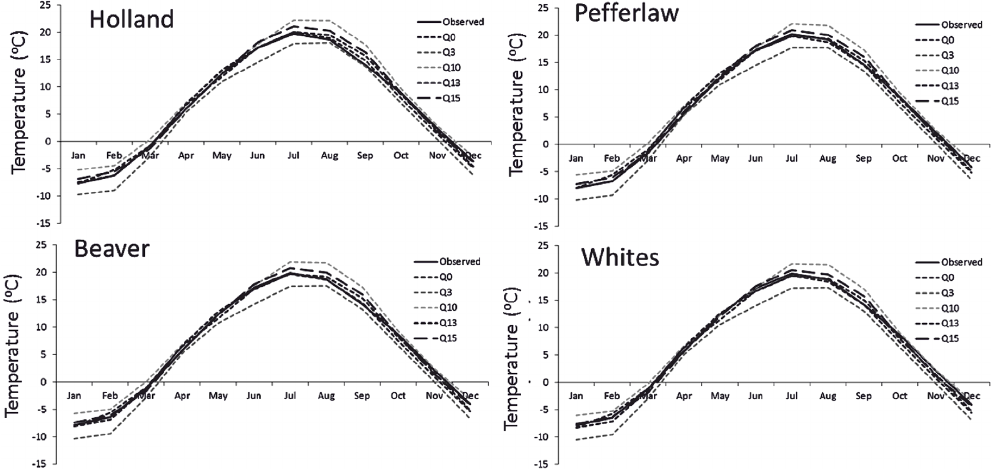
Figure 2. Comparison of monthly temperature data from 5 ensemble members (Q0–15), regionally downscaled using PRECIS, with observed meteorological station data over 30 year baseline period (1968–1997).